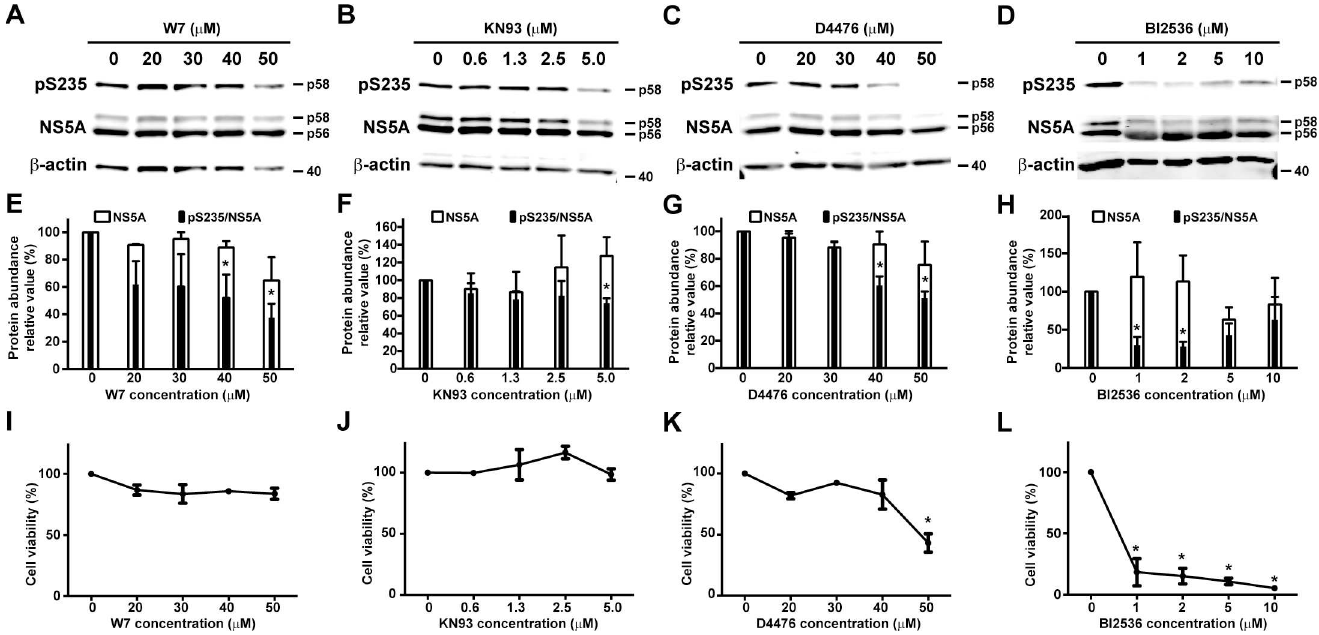
Fig 2. Calmodulin, CaMKII, CKI α and PlkI inhibitors reduced HCV NS5A S235 phosphorylation in the HEK293Tcells. (A-D) Representative and (E-H) summary of the immunoblotting for NS5A and NS5A phosphorylation at S235 (pS235)in the NS3-5A transfected HEK293T cells. One day after the transfection, the cells were exposedto the inhibitorsfor 2 days before the immunoblotting analysis.Values are Mean ± SEM (n = 3). Asterisk indicates significancei.e. p < 0.05,t-test againstthe values in the vehicle controls (0 μ M). Protein intensities were measuredwith the Li-Cor Odyssey scannerand software and adjustedfor the loadingswith the β -actinintensity. Relativeabundance was normalizedagainstthe values under the vehiclecontrol (0 μ M). (I-L) Cell viabilityassessed with the MTT assay. The cells were exposedto the inhibitorsfor 2 days before the viabilityassay. Valuesare Mean ± SEM (n =